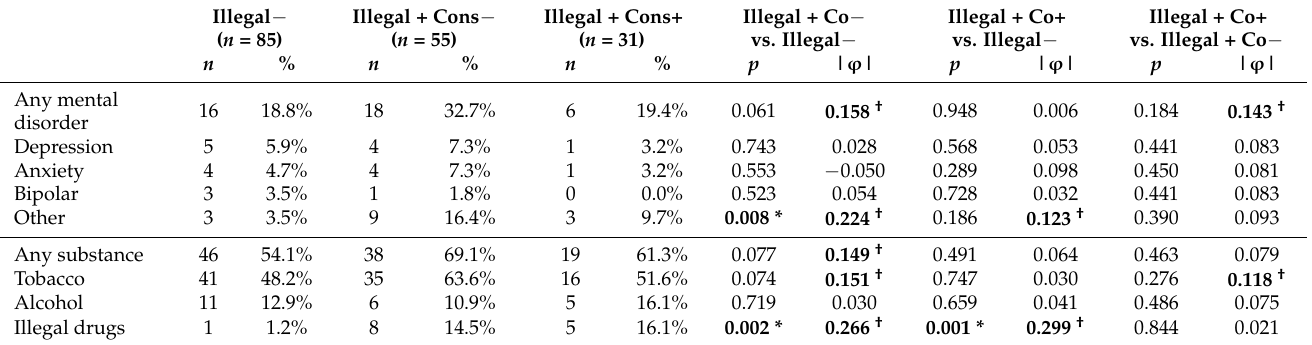
Table 3. Comparison between the groups for comorbid mental disorders and